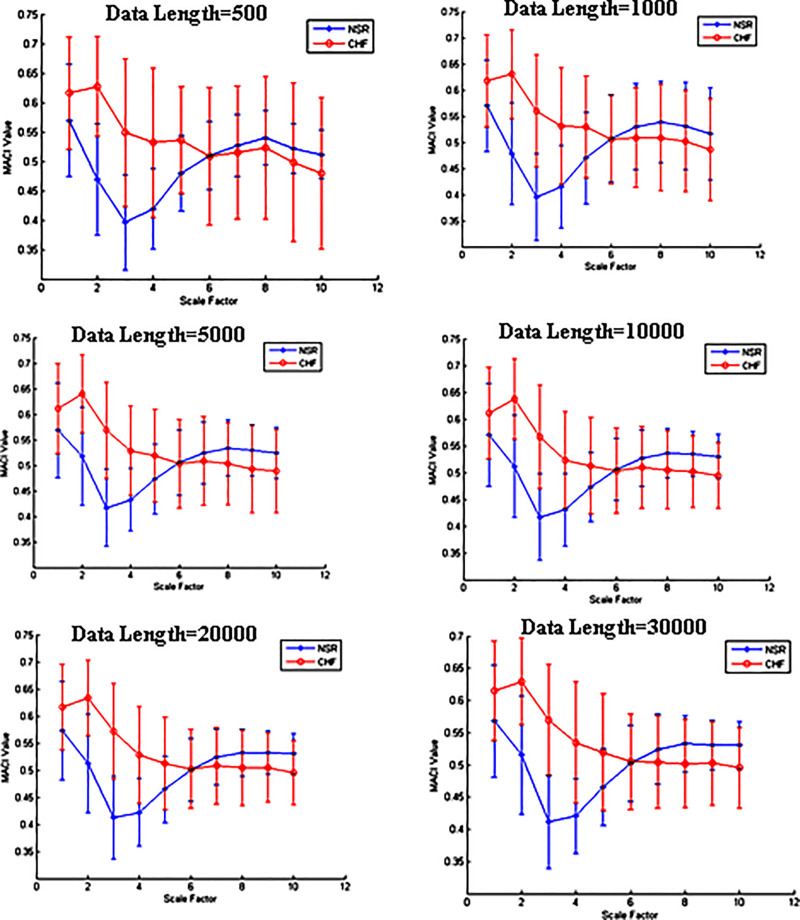
Variations in the MACI values at different time scales with signal length.